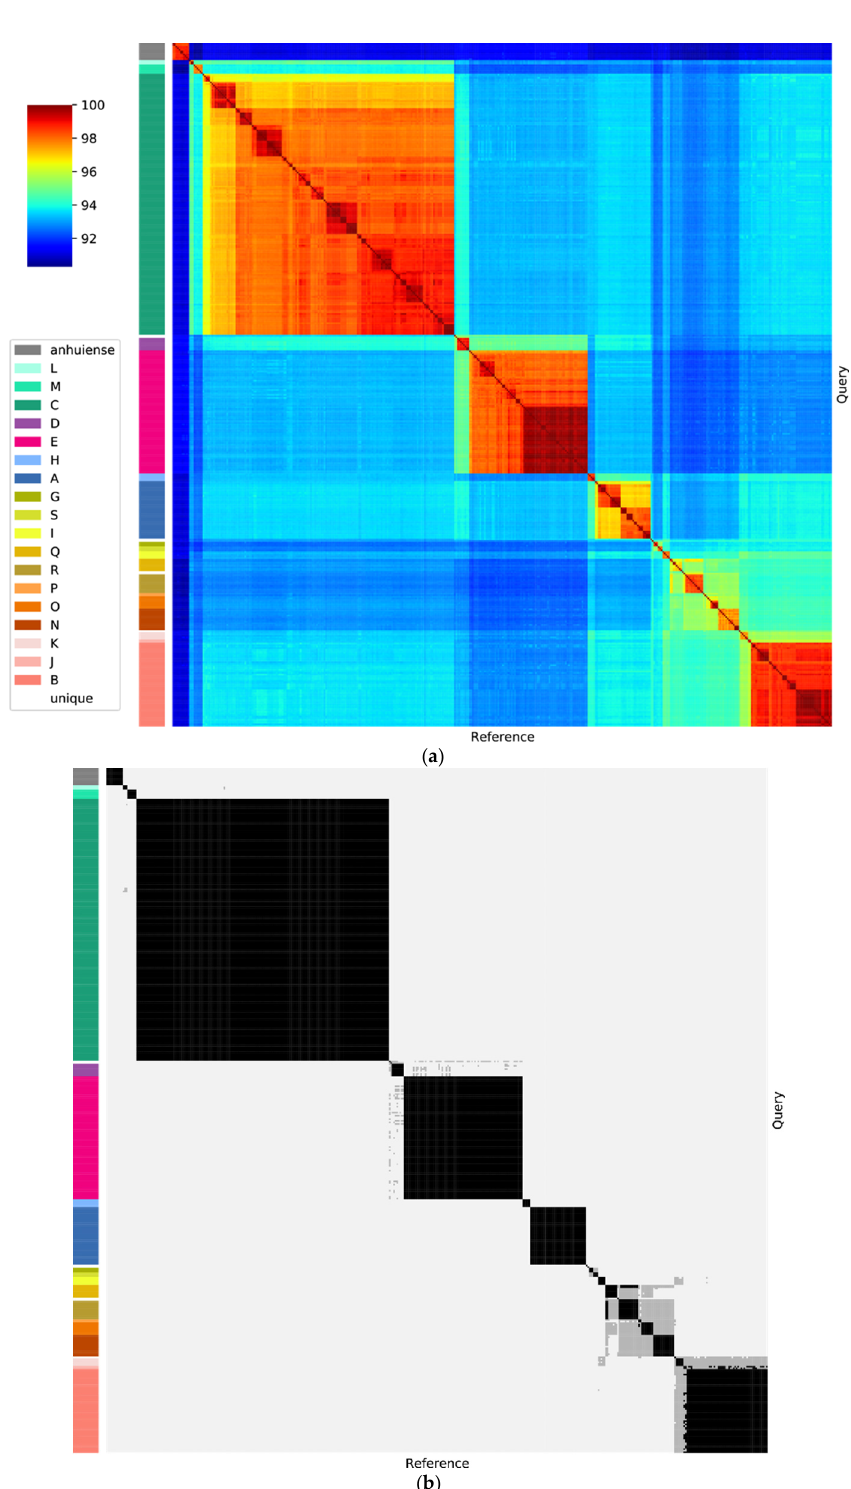
Figure 4. Pairwise average nucleotide identity (ANI) between all genomes in the Rlc and R. anhuiense . The bars at the left indicates genospecies of each genome. ( a ) Continuous color scale. ( b ) The same data, but with thresholds to indicate values over 95% (grey) or over 96% (black).